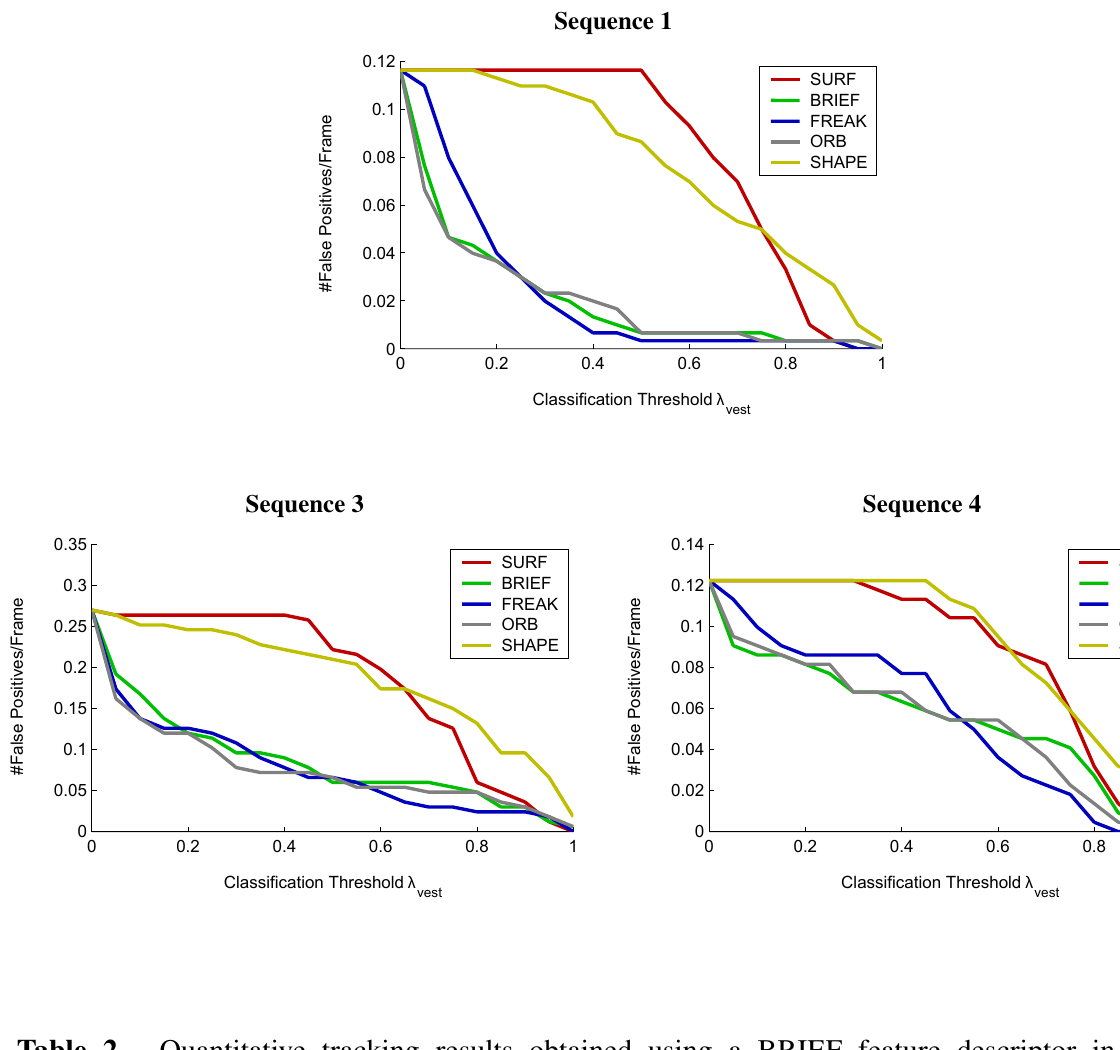
Table 2. Quantitative tracking results obtained using a BRIEF feature descriptor in combination with a classification threshold. λ